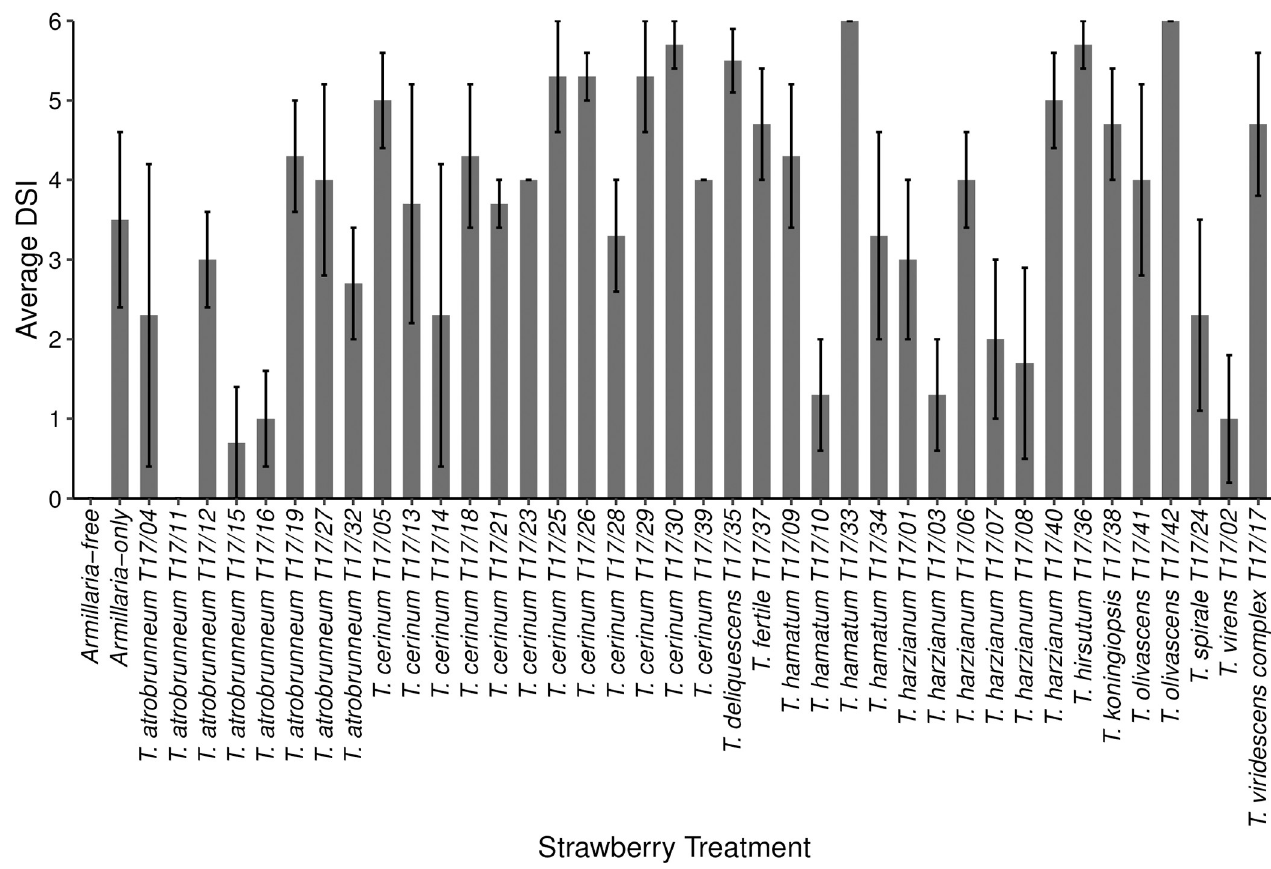
Fig 1. The average disease severity index (DSI) of Armillaria mellea CG440 infection in strawberry plants after three months in plants pre-colonised with Trichoderma spp. The DSI was measured on a scale from 0–6, where 0 = healthy plants. The error bars represent the standard error of the mean (n = 3).